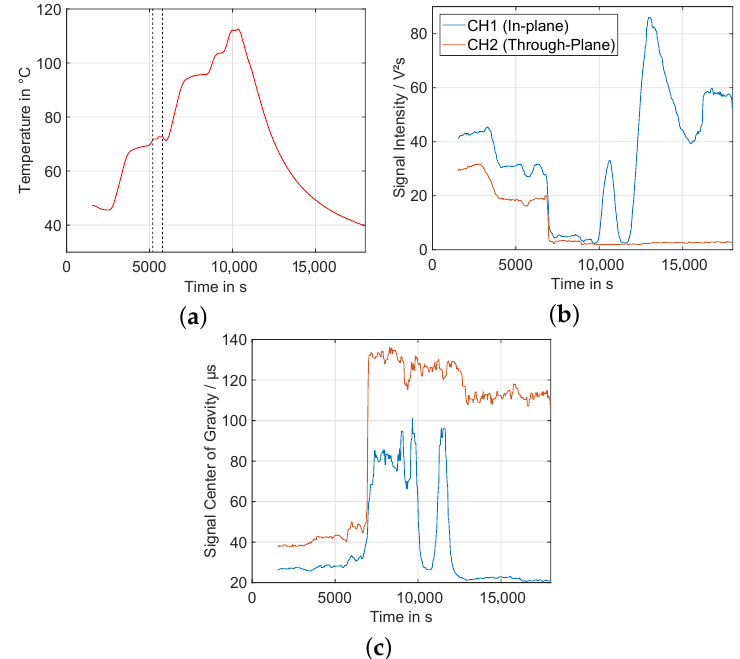
Figure 16. Left ( a ): Temperature over time during experiment. Marked range shows timeframe of temperature regulation malfunction. Center ( b ): Signal intensity over time. Right ( c ): Signal center of gravity over Time (legend same as ( b